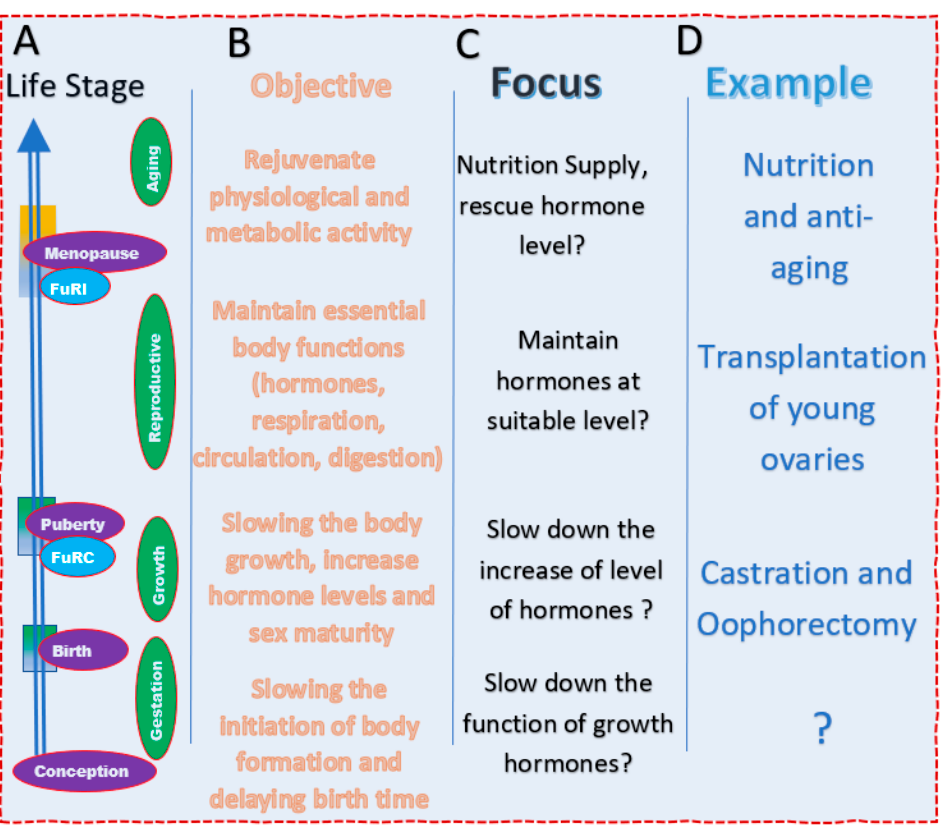
Figure 6. Strategies of lifespan extension based on the principal law of lifespan. ( A ) The key transitional points of the life cycle. ( B ) The objectives of different life stages. ( C ) Strategic focus points in different life stages. ( D ) The example that may be pursued to support the strategies.